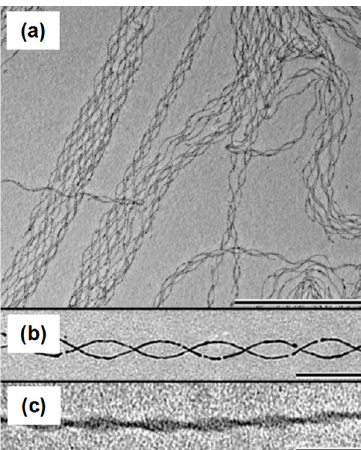
Figure 11. ( a , b ) High- and low-magnification TEM images of double-helical Au NWs and ( c ) a twisted nanoribbon composed of 43a and 43c . Scale bars: ( a ) 500 nm and ( b , c ) 100 nm. Reproduced with permission from Reference [91].